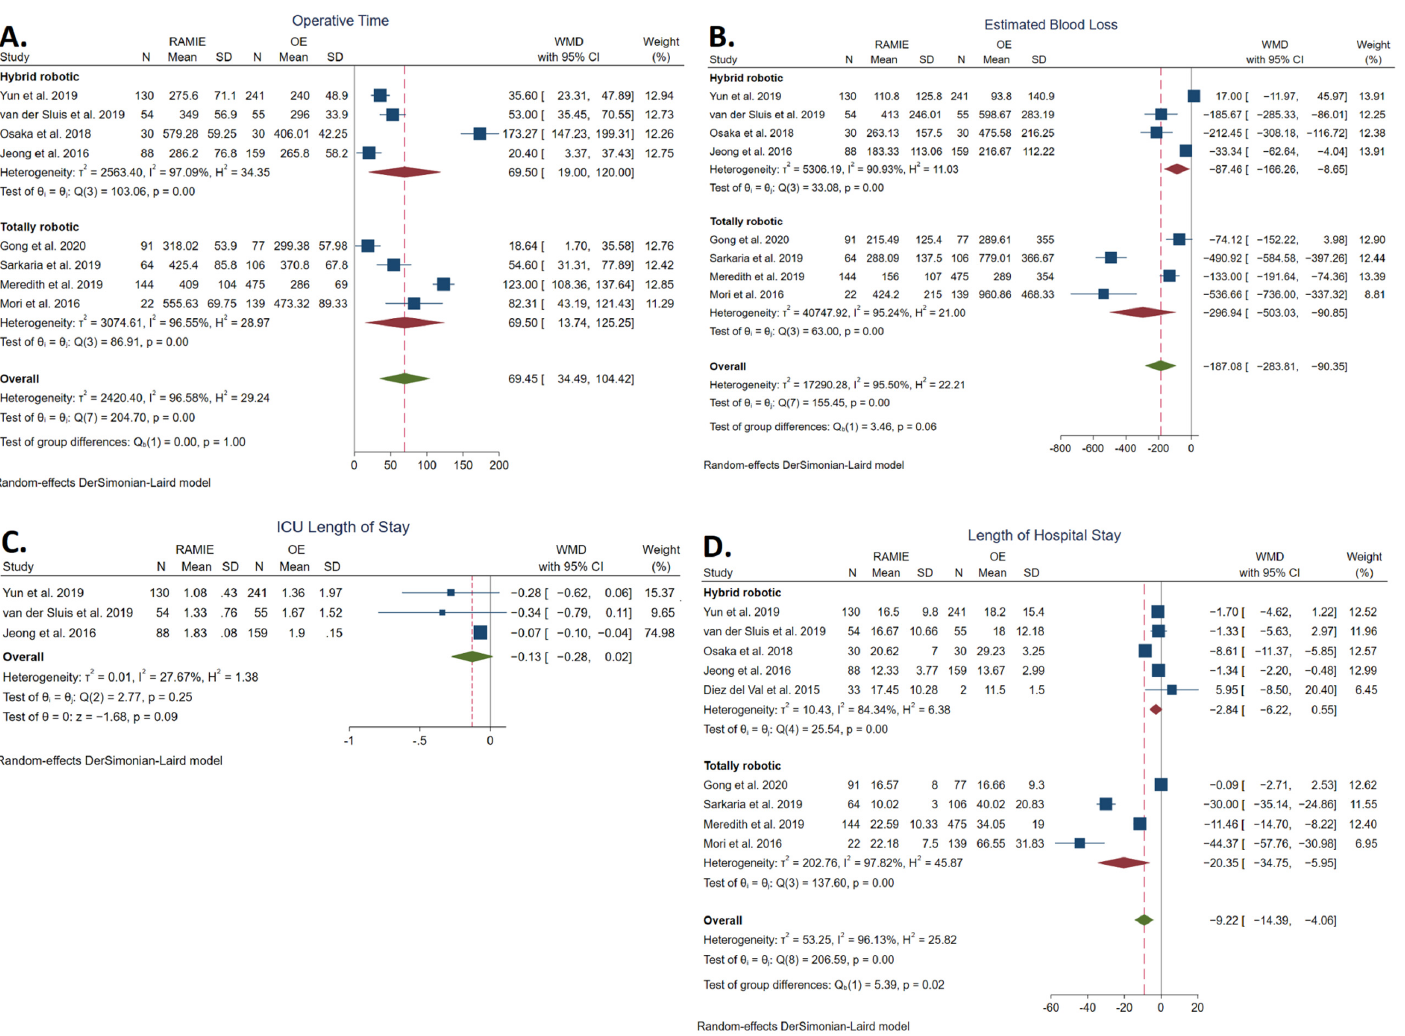
Figure 4. Forest plots of operative time ( A ), estimated blood loss ( B ), intensive care unit (ICU) length of stay ( C ), and hospital length of stay ( D )